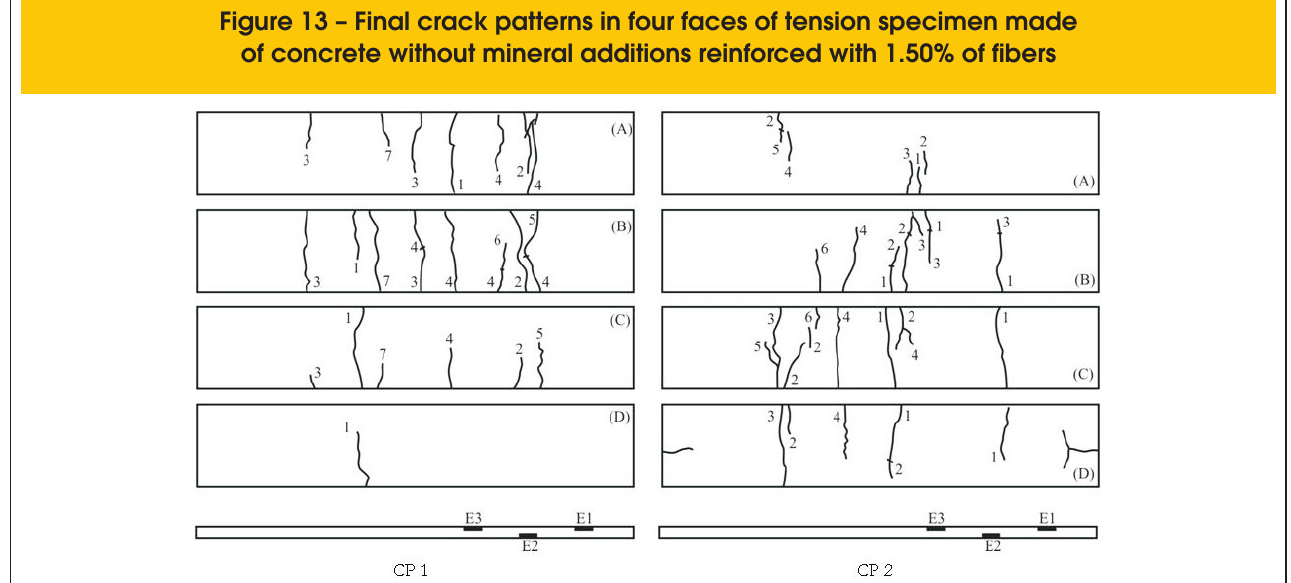
Figure 13 – Final crack patterns in four faces of tension specimen made of concrete without mineral additions reinforced with 1.50% of fibers